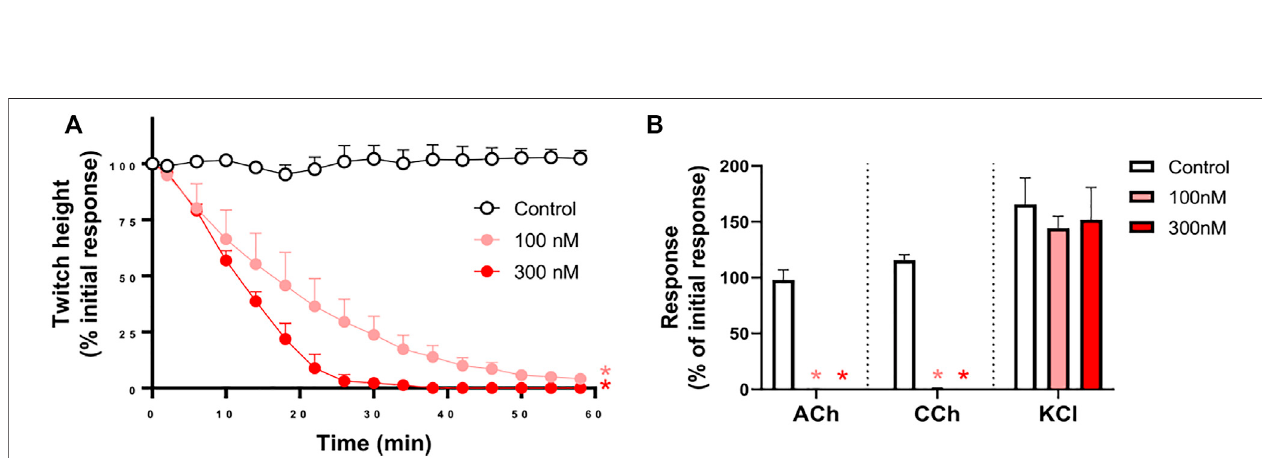
FIGURE 5 | The concentration-dependent in vitro neurotoxic effects of α -elapitoxin-Oh3a (100 – 300 nm) on (A) indirect twitches and (B) responses to exogenous agonists ACh (1 mM), CCh (20 µM) and KCl (40 mM) in the chick biventer cervicis nerve-muscle preparation. * p < 0.05, signi fi cantly different from (A) control at 60 min (one-way ANOVA; n = 4) or (B) pre-toxin response to same agonist (paired t -test, n = 4).